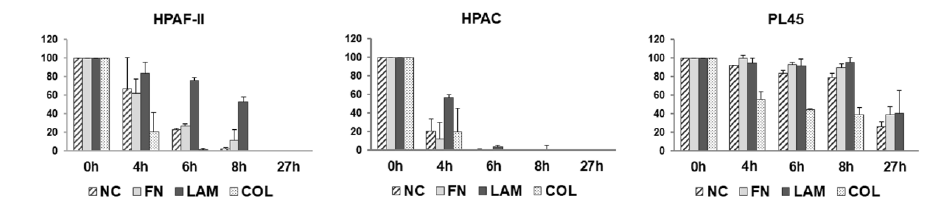
Figure 5. Cell migration. Bar graphs showing the closure of the wound at the indicated time points in HPAF-II, HPAC, and PL45 cells cultured on FN, LAM, COL, or without coating (NC). Bars represent the open wound, and data are expressed as the % vs. time point 0 h. Data are mean ±